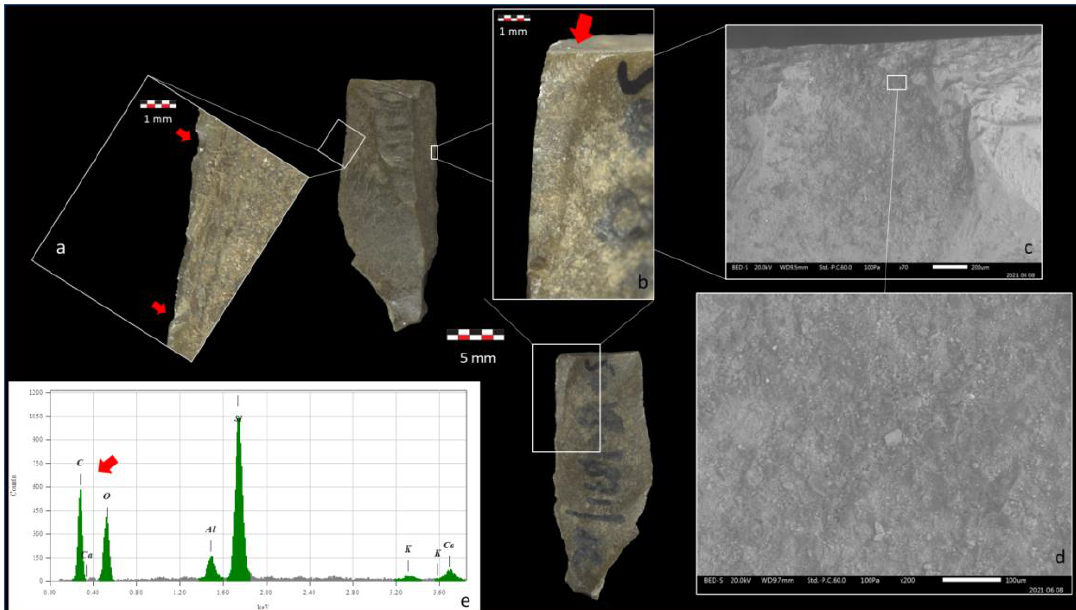
Figure 15. Macroscopic details of the impact damage present on the curved backed piece LB57A.518- 4871-1c identified as a projectile element. The piece presents a combination of: a) obliquely oriented lateral scarring and; b) a hinge-terminating bending break with a long propagation phase on the right lateral side. Possible hafting glue observed on the back: c) backscattered electron image showing its presence on the backed edge of the tool; d) detail of the amorphous organic residue, showing